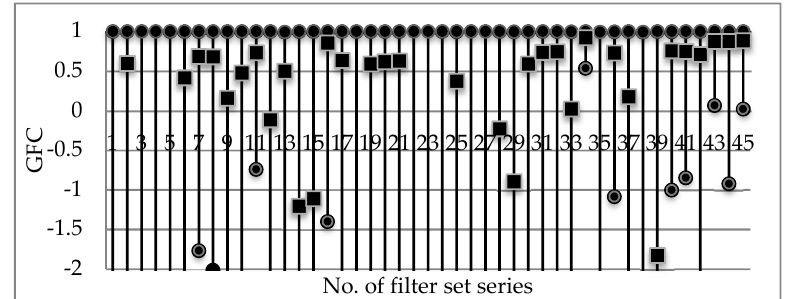
Figure 2. Overall performances of the 45 series of filter sets in terms of GFC, where the upper round marker denotes the maximum value; the middle square denotes the mean; and the lower round denotes the minimum (some of the minimums with negative value less than −2 are not be displayed). Sensors 2018 , 18 , x